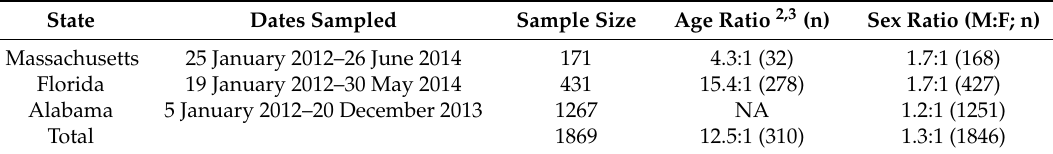
Table 1. Raccoon risk model sample data for pine-dominated landscapes of Massachusetts, Florida, and Alabama: 2012–2014.